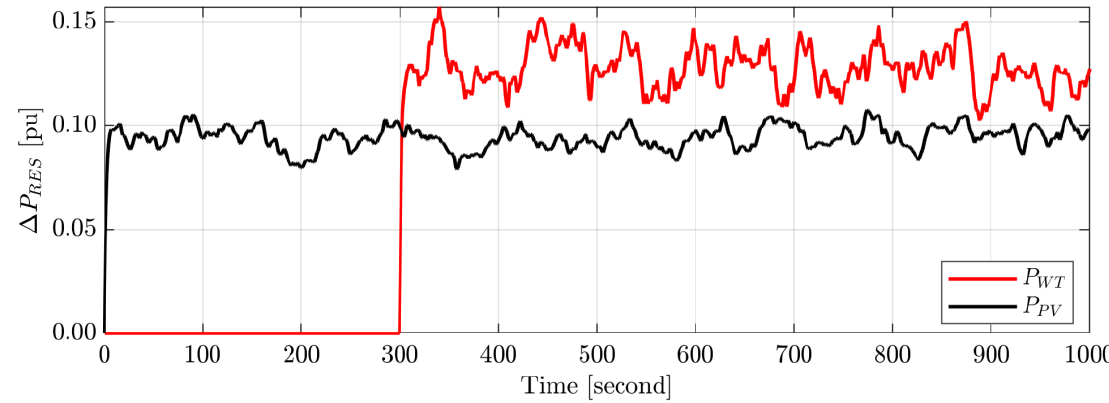
Figure 14. Wind and solar PV power profiles for the scenario B.